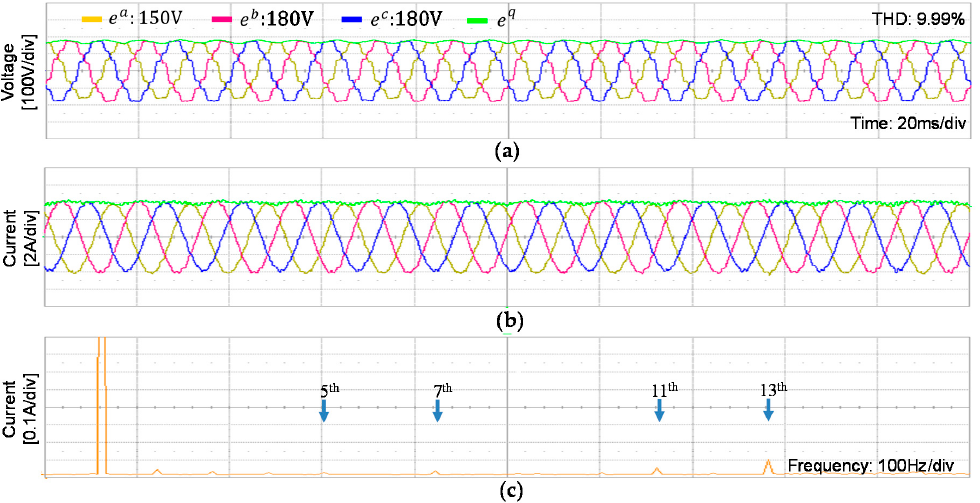
Figure 19. Experimental results of the proposed controller under three-phase distorted and imbal- anced grid voltages with e a drop to 83.33% of the nominal value. ( a ) Three-phase grid voltages; ( b ) three-phase grid currents; and ( c ) FFT result of phase- a